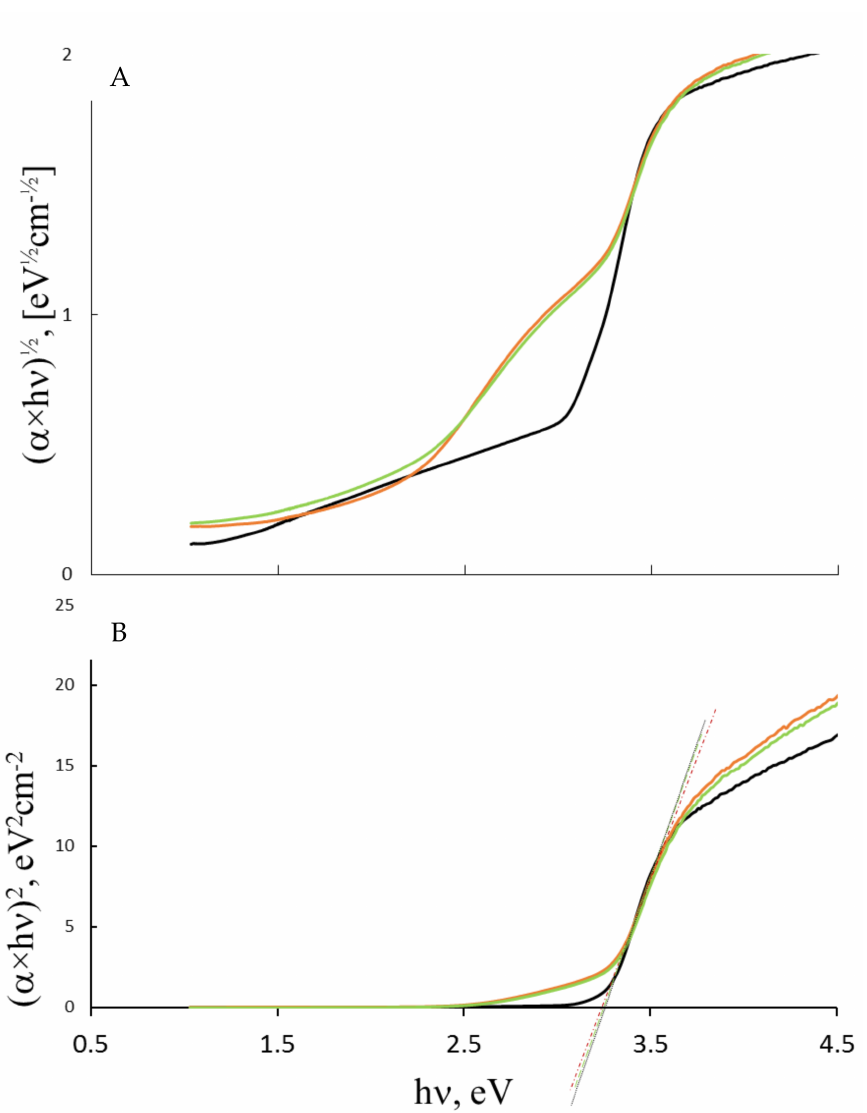
Figure 4. The Tauc plots of the catalysts particles; intra gap states ( A ); band gap estimation ( B ); black line represents commercial anatase (S0), green line represents S1 and red line